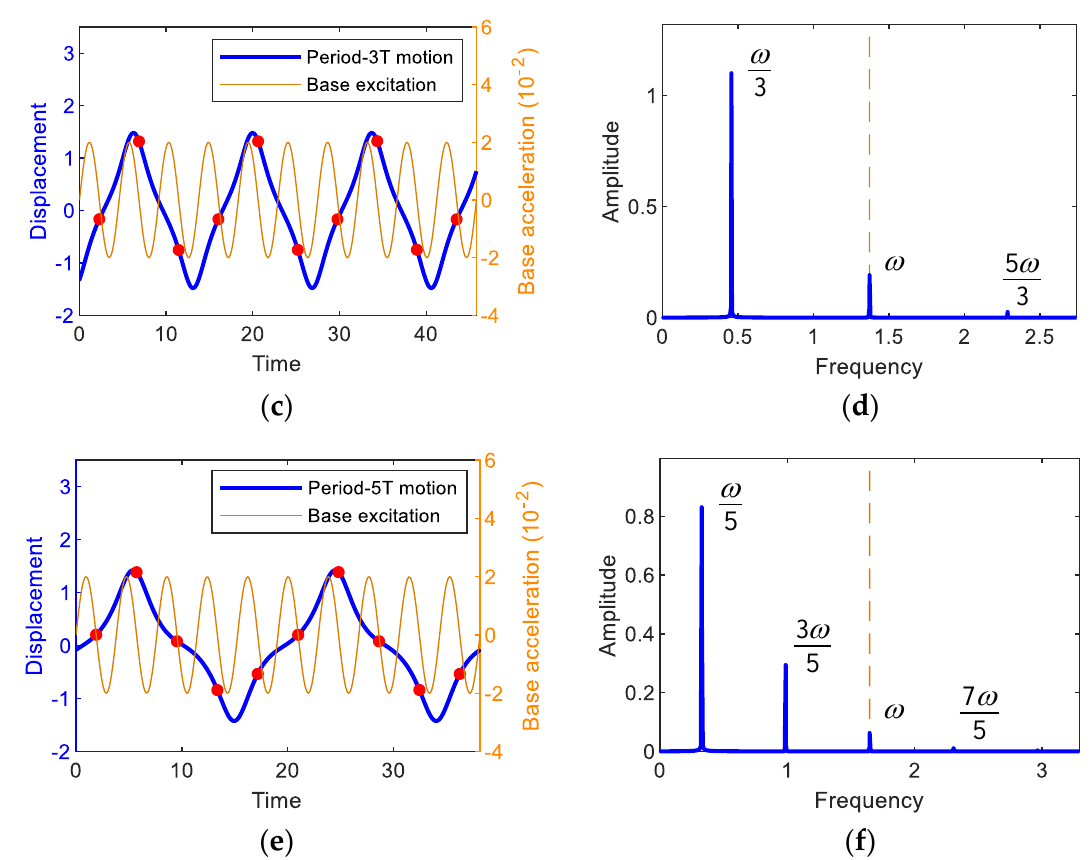
Figure 5. ( first column ) Time responses and ( second column ) the associated amplitude spectra, obtained by the fast Fou- rier transform. In ( a,b ) the period-1 T motion when A = 0.02 and ω = 0.82, in ( c,d ) the period-3 T motion when A = 0.02 and ω = 1.37, and in ( e,f ) the period-5 T motion when A = 0.02 and ω = 1.65. The base excitation used for this simulation is also presented for comparison. In ( a , c , e ), the red dots indicate the stroboscopic projections of the oscillations, which are syn- chronized with the period T of the base excitation.